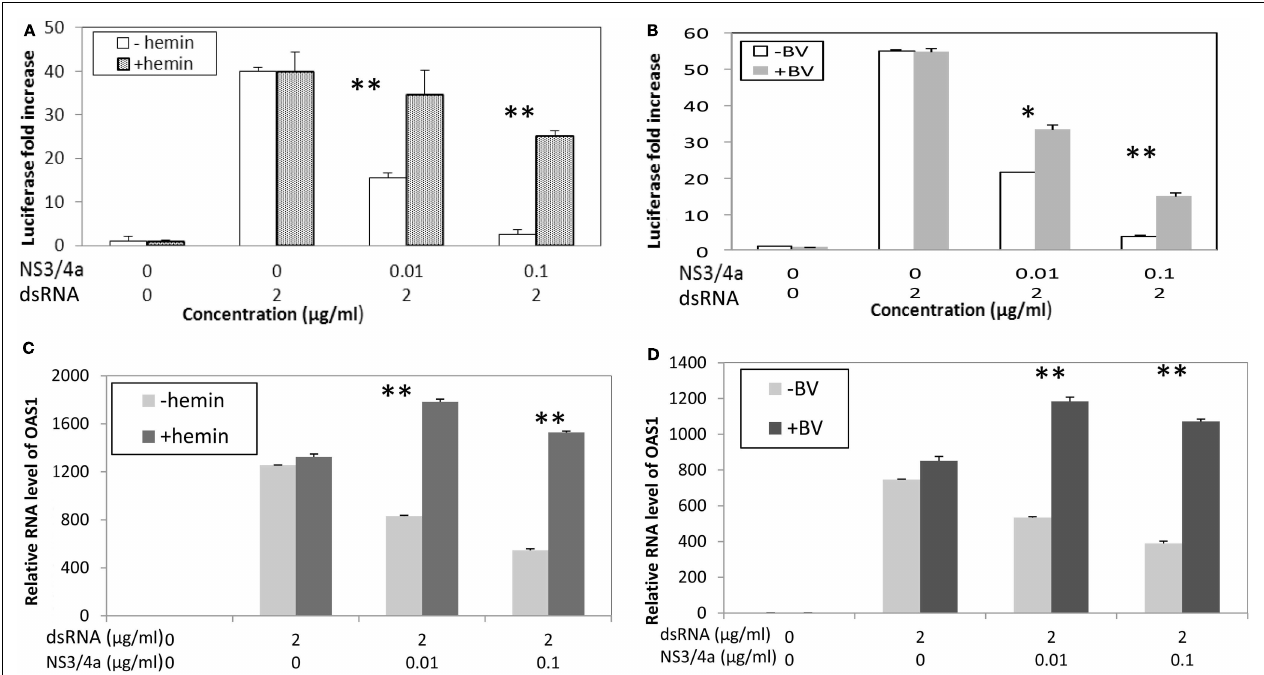
cell culture incubations, and then three replicates for luciferase assay per incubation). (C,D) Parallel experiments showing that heme and BV can restore interferon stimulated response genes (ISRG) after inhibition with NS3/4A protease. HEK 293 cells were transfected with dsRNA with or without HCV NS3/4A plasmid then incubated with heme or BV for same time and concentrations as (A,B) OAS-1 mRNA was measured using Real Time RT-PCR. Each point is the mean of six determinations as described for (A,B) ** p < 0.01; * p < 0.05; NS, not significant. (With permission Zhu et al.,